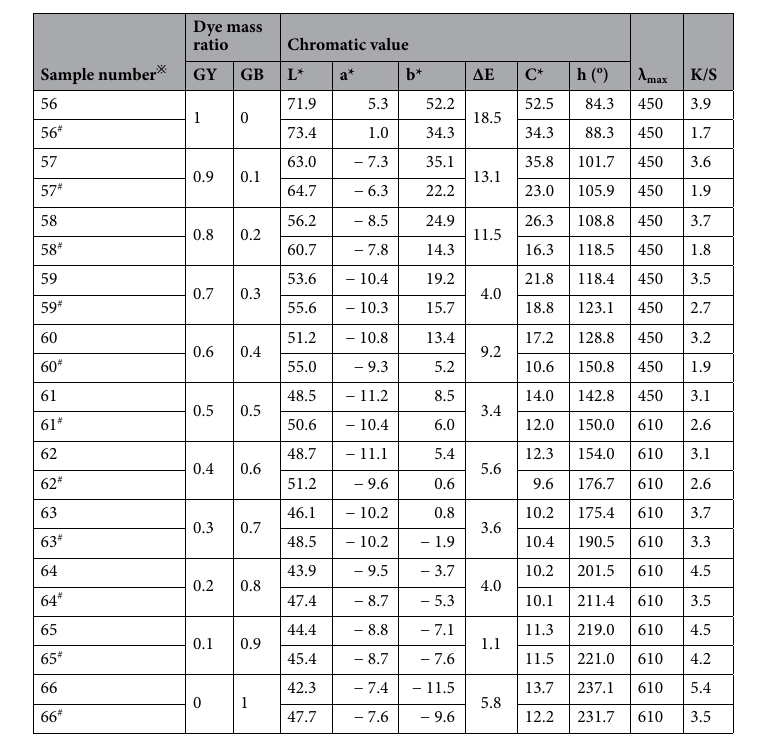
Table 3. Chromatic values of wool yarns dyed with binary mixtures of GY and